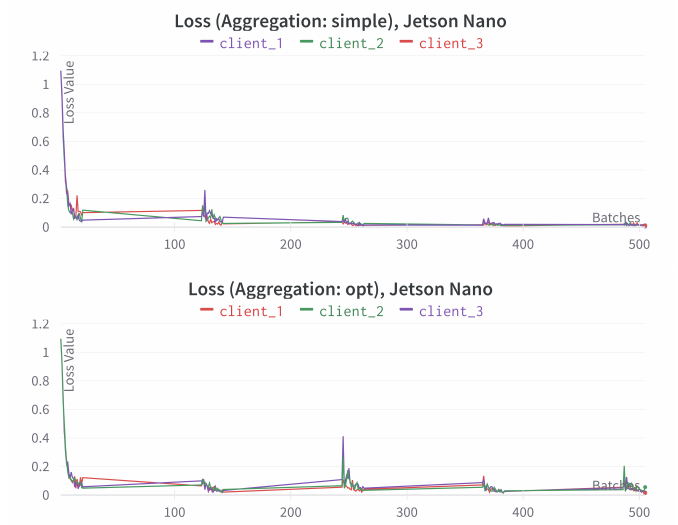
Figure 7. Loss comparison for different federated aggregation methods using Jetson Nano devices. x-axis represents the incremental number of training mini-batches, y-axis represents